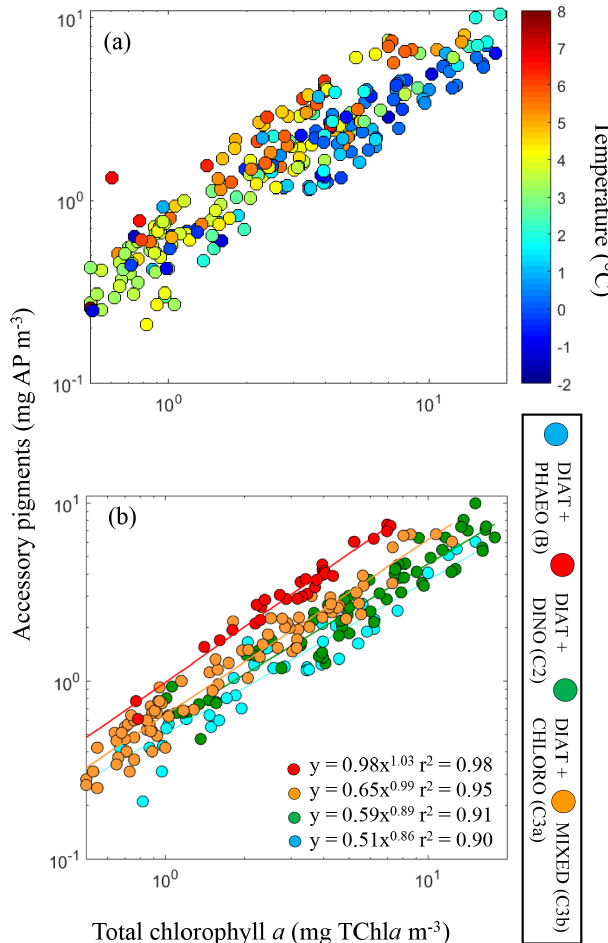
Figure 7. Relationship between total accessory pigments (mgAPm − 3 ) and total chlorophyll (mgTChl a m − 3 ) on a logarithmic scale, with the points (stations) according to tempera- ture (a) and colour-coded according to phytoplankton community cluster group (see details in Fig. 4) (b)